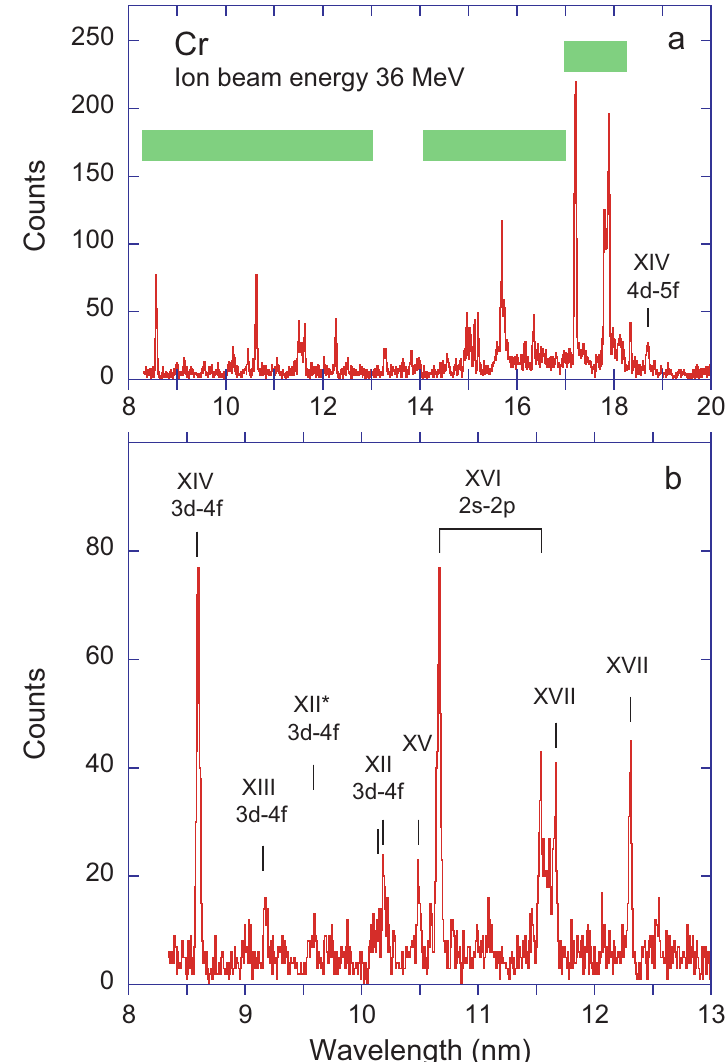
Figure 12. Beam-foil spectra of Cr at an ion beam energy of 36MeV. Observation at the foil. Line width (FWHM) 0.035nm. Several spectral features can be identified with yrast transition arrays. The green rectangles in spectrum ( a ) show the positions and ranges of the detail spectra in spectrum ( b ) and in Figure 13a,b. The strongest lines in spectrum ( b ) are identified by the spectrum